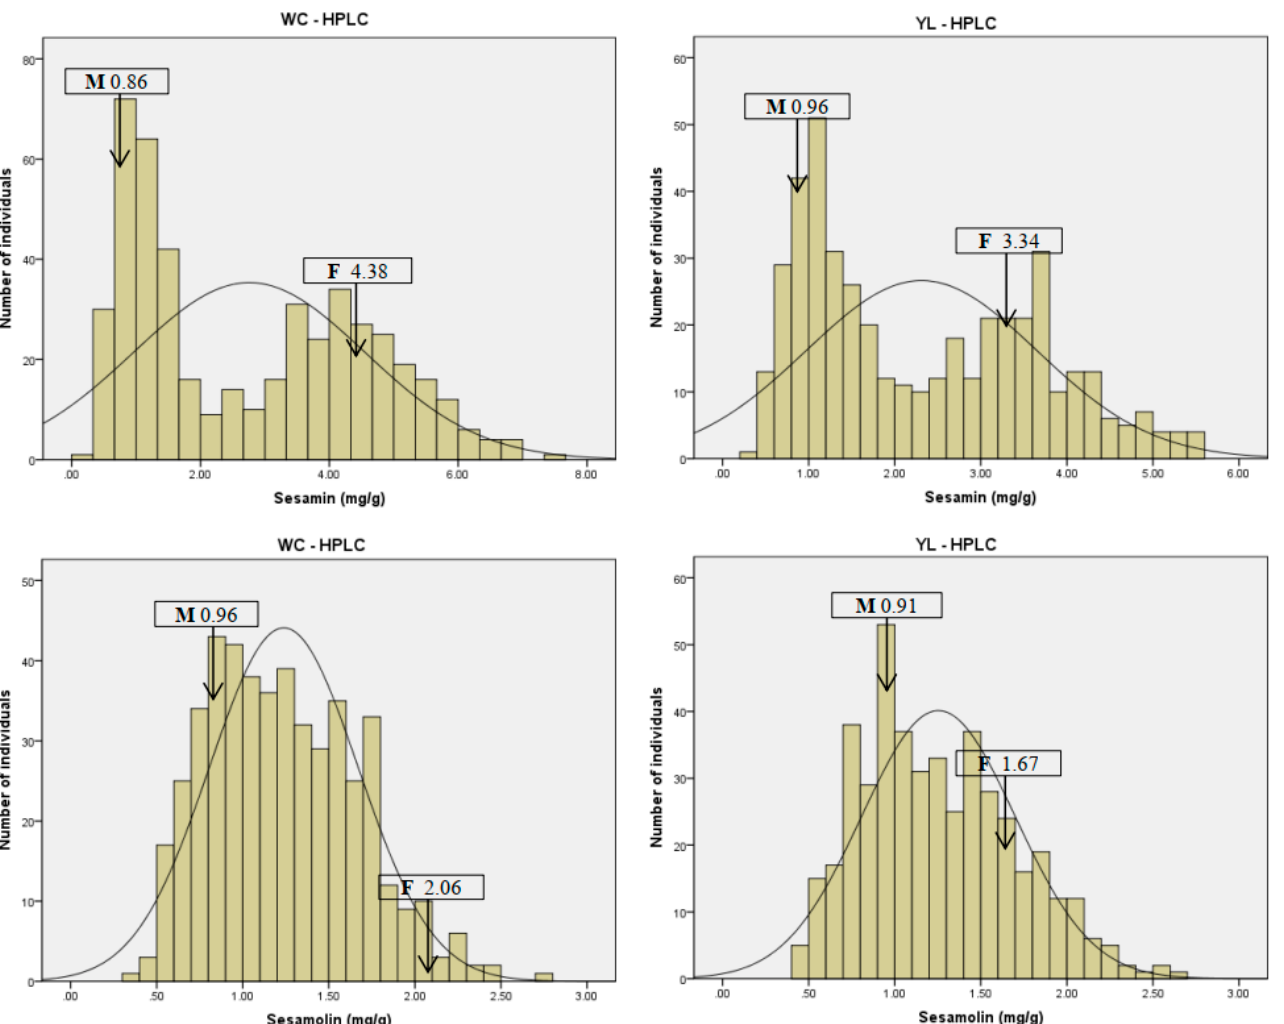
Figure 1. Frequency distribution of sesamin and sesamolin in Zhongzhi No. 13 × ZZM2748 RIL population of two environments. The abscissa shows the sesamin or sesamolin content, and the ordinate indicates the frequency of distribution. WC, Wuchang; YL, Yangluo; mean of two parents is indicated at the top of each histogram, with F and M representing Zhongzhi No. 13 (female parent) and ZZM2748 (male parent),